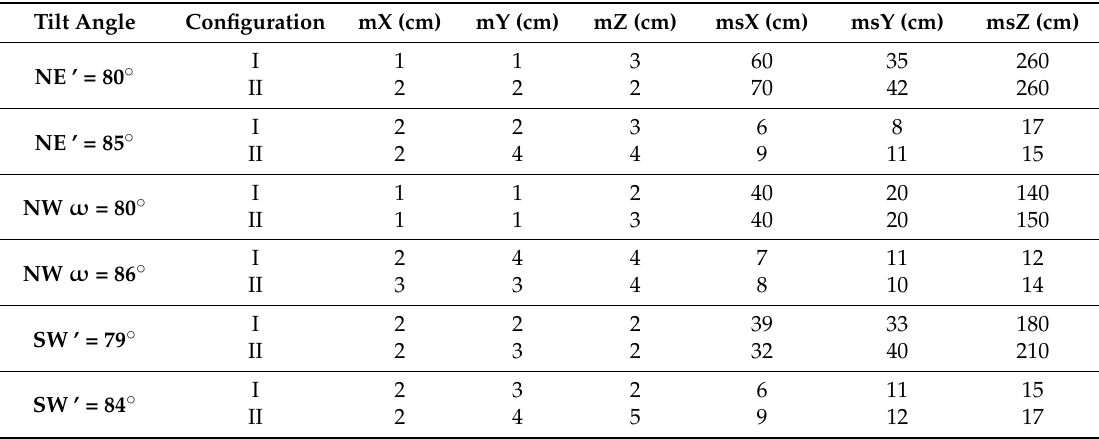
Table 8. RMSE values of the point coordinates calculated using a simplified set of collinearity equations and RMSE values of the point coordinates calculated using the standard collinearity equations for two variants of distribution of the control and tie